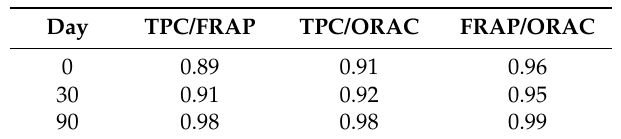
Table 3. The correlation (R 2 ) between total phenolic content and antioxidant activity methods and between two different antioxidant activity methods (FRAP and ORAC) obtained from cheeses fortified with free (+)-catechin.